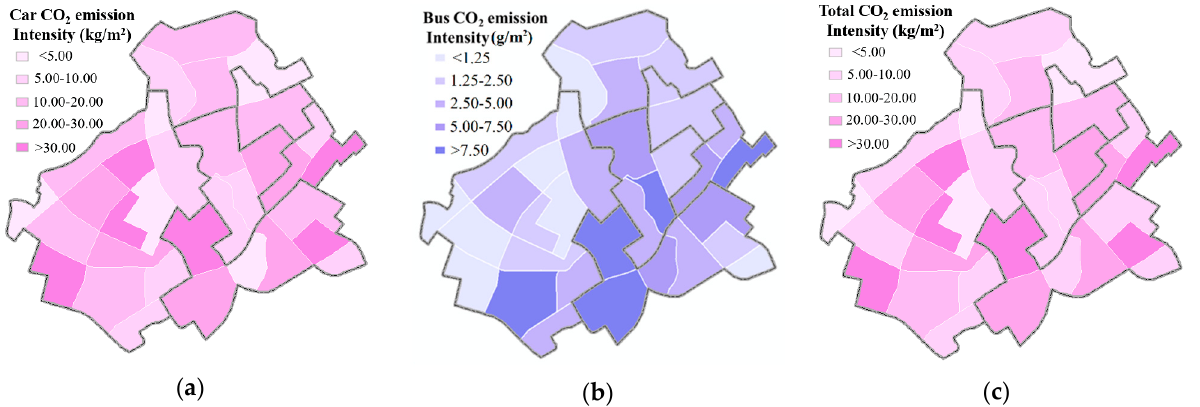
Figure 9. Spatial distribution of the intensity of the emissions of each TAZ. ( a ) Car CO 2 emission intensity; ( b ) bus CO 2 emission intensity; ( c ) total CO 2 emission intensity.